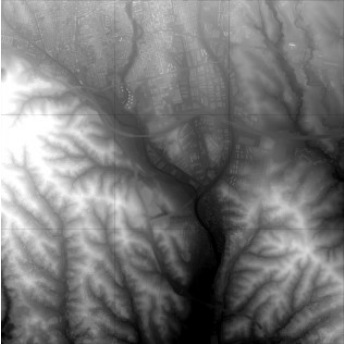
Figure 5. Reference DEM derived from LIDAR data for